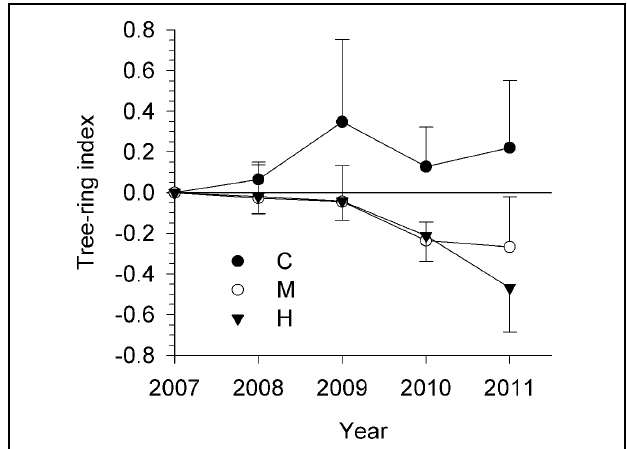
FIGURE 2 | Measurement of growth rings in the 5 years up to 2011 for the three study sites (C, control trees; M and H are moderately and heavily defoliated trees). Vertical bars represent the SD calculated among six